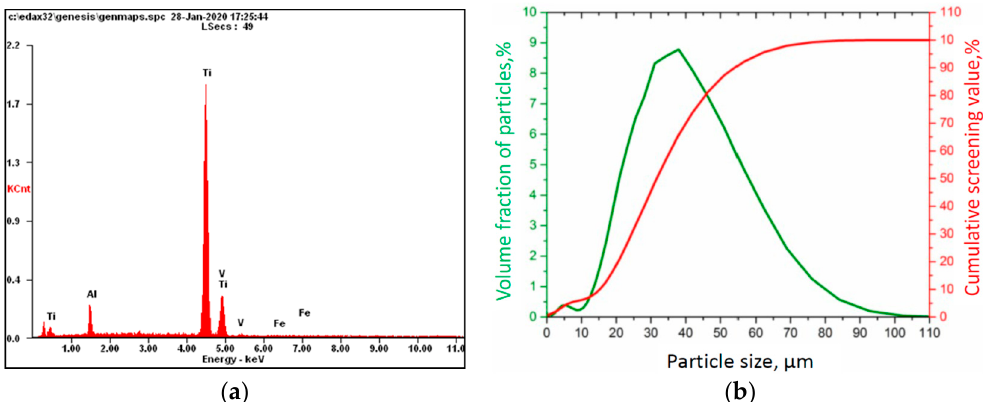
Figure 4. Test results of Ti6Al4V powder. ( a ) Volume share of elements on the particle surface from Figure 2b and ( b ) volume share and cumulative screening value depending on powder particle size. Table 2. Operation characteristics of the Orleas Creator device.